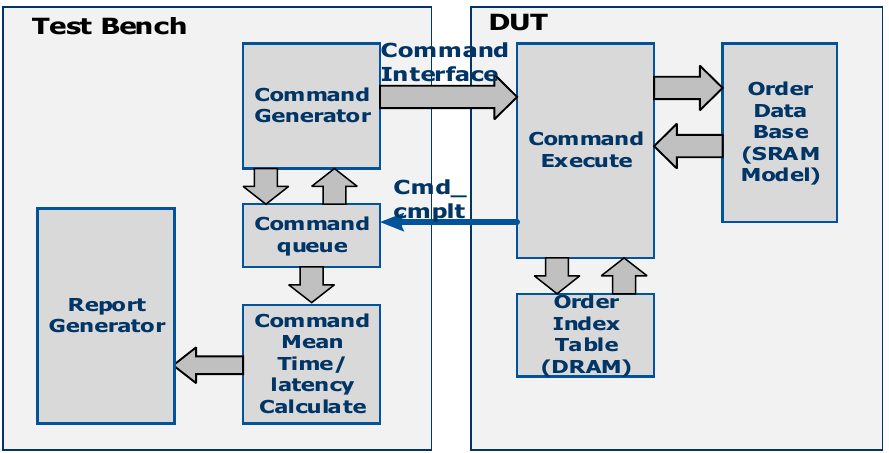
Figure 9. Block diagram of the SystemVerilog test bench and